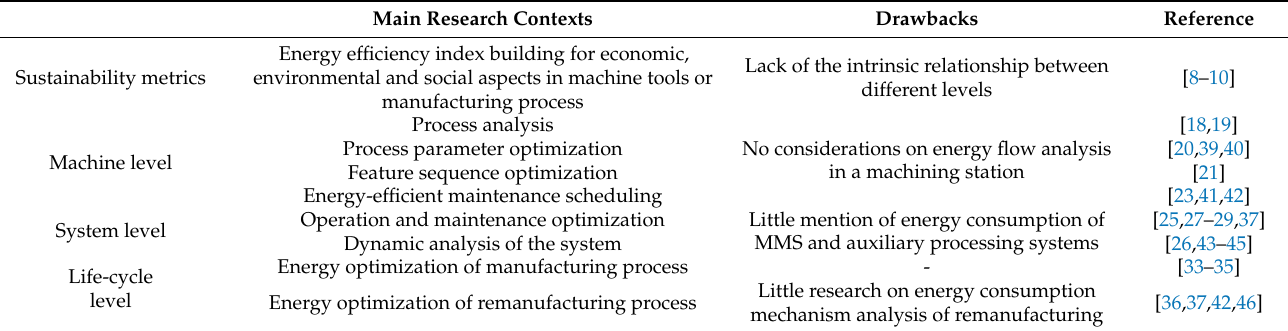
Table 1. Summary of literature related in different levels. Main Research